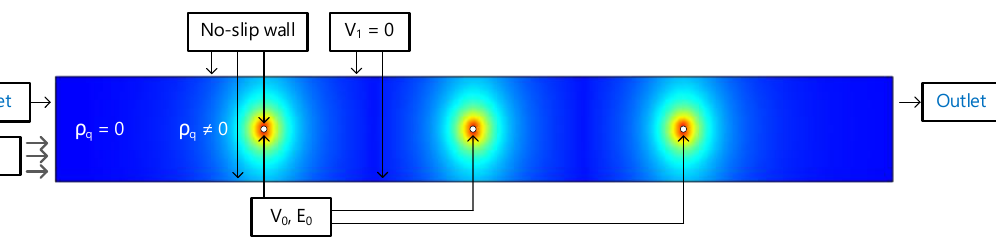
Table 1. Boundary conditions applied to the ESS model.